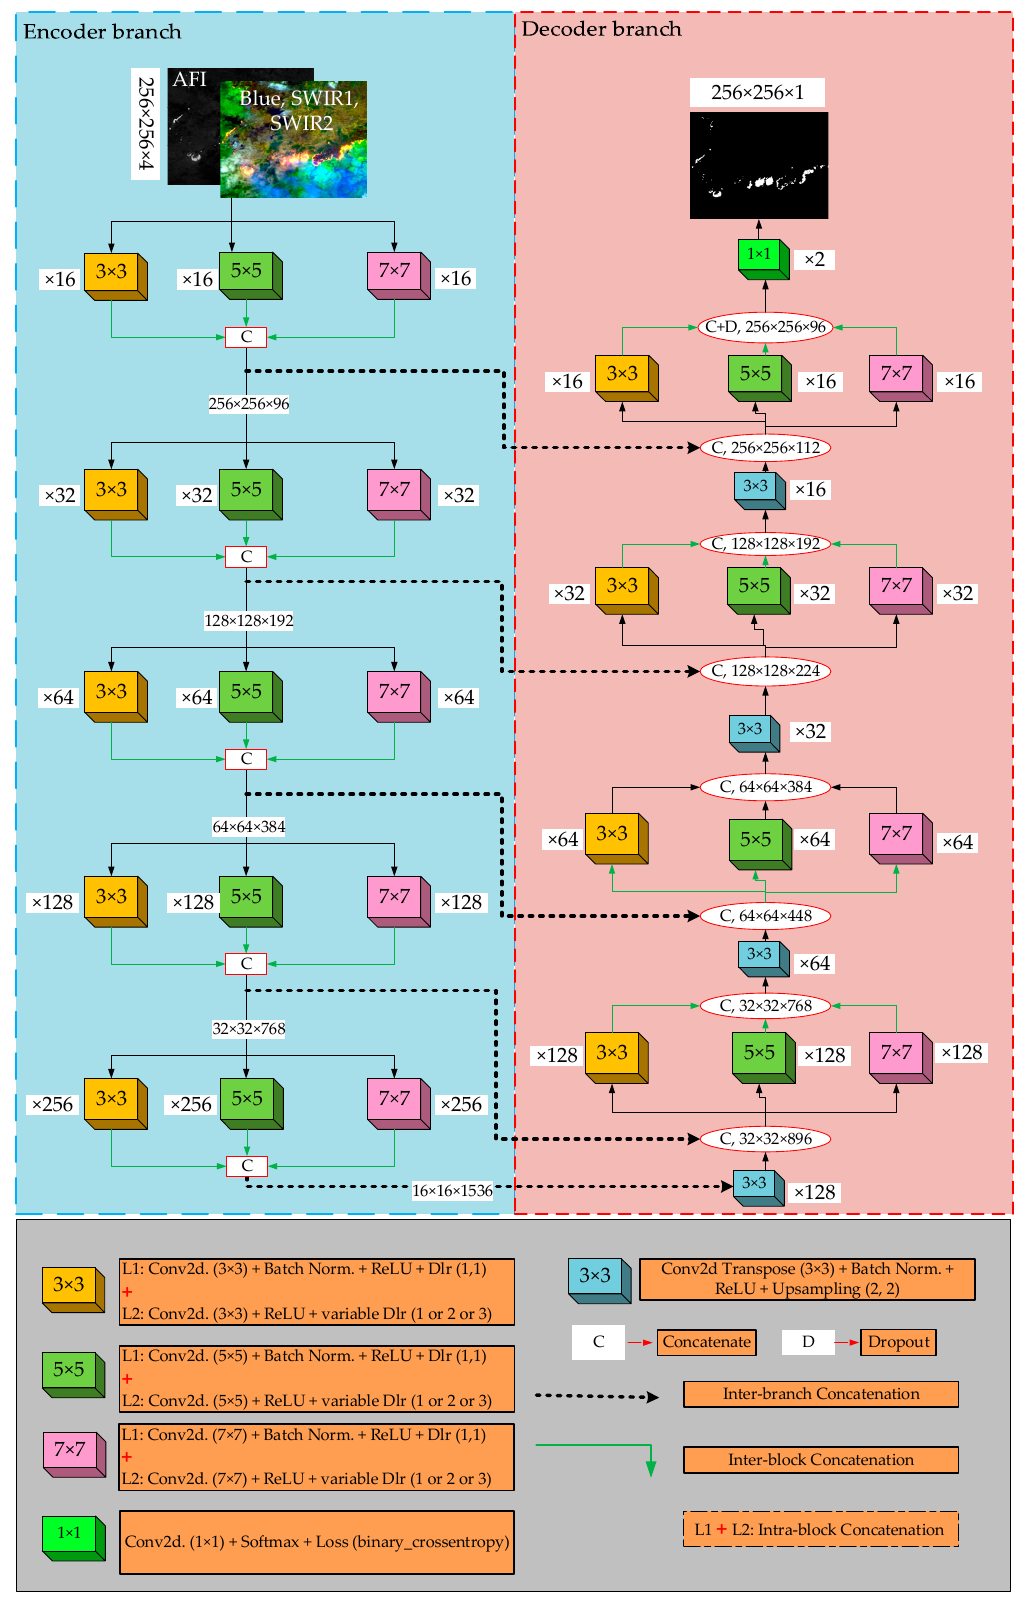
Figure 5. The proposed network for AFD. “Conv2d (k × k)” shows the convolutional kernel with the size of k × k; “Batch Norm.” denotes batch normalization; “ReLU” denotes the rectified linear units. “Dlr” denotes dilation rate.